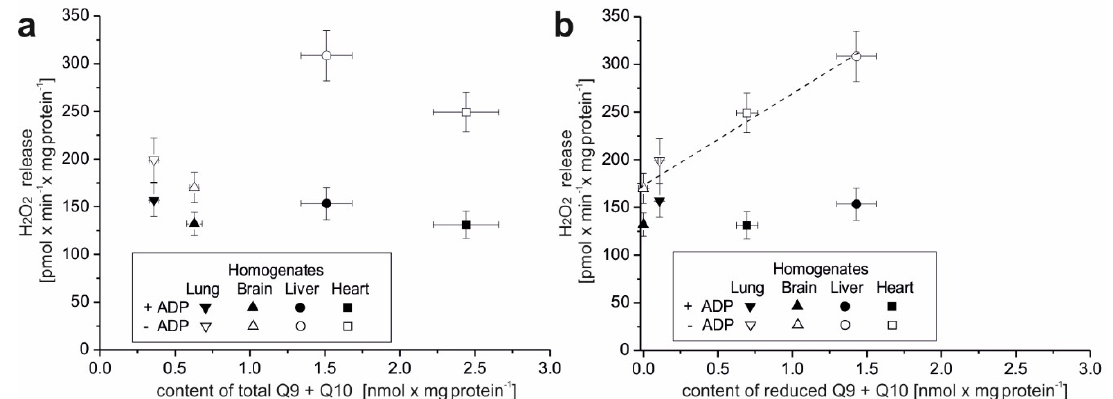
Figure 1. H 2 O 2 release versus the content of total ( a ) and reduced ( b ) Q pools (Q9 + Q10) in rat tissue homogenates. H 2 O 2 release measurements were performed in the absence or presence of ADP with succinate and malate plus glutamate as mitochondrial respiratory substrates. The total and reduced Q9 + Q10 pools were measured under fully oxidizing conditions (no respiratory Q-reducing substrates). Mean ± SD. ( b ) The linear regression between H 2 O 2 release in the absence of ADP and the content of reduced Q9 + Q10 is shown (r = 0.988, p = 0.01).